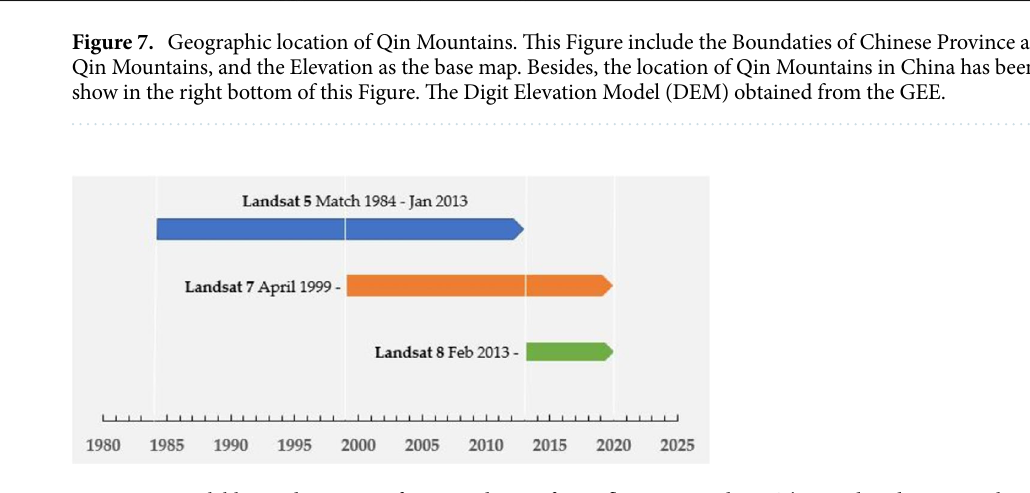
Figure 8. Available Landsat images from Landsat surface reflectance products. The Landsat datasets such as Landsat 5, Landsat 7 and Landsat 8, which produced by different sensors. Although they have same resolution, the time series are